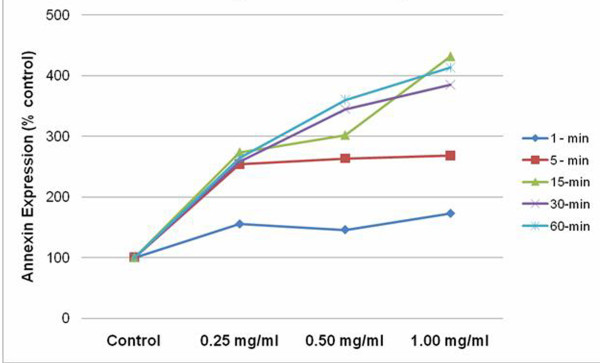
Annexin-V detection evaluated by flow cytometry, demonstrates a dose and time dependent increase in early apoptosis following ICG exposure. Data expressed as percent of control.